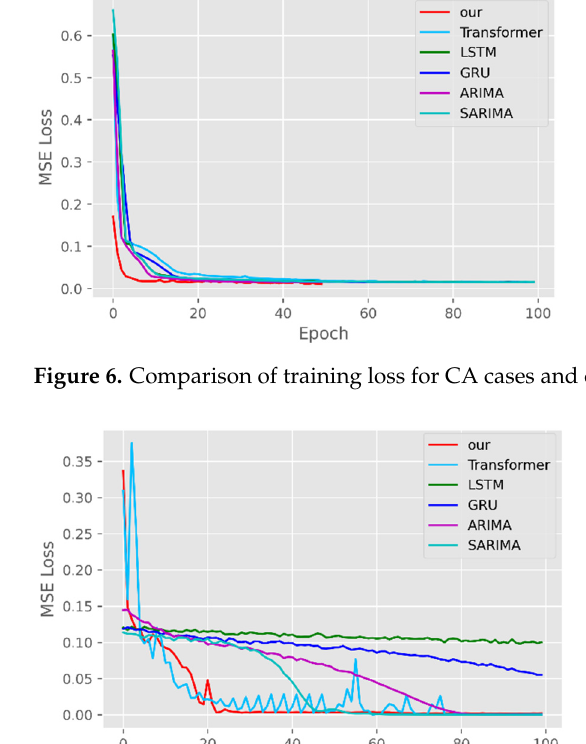
pensity to predict outcomes for various sets of data. Figures 6–11 demonstrate how well